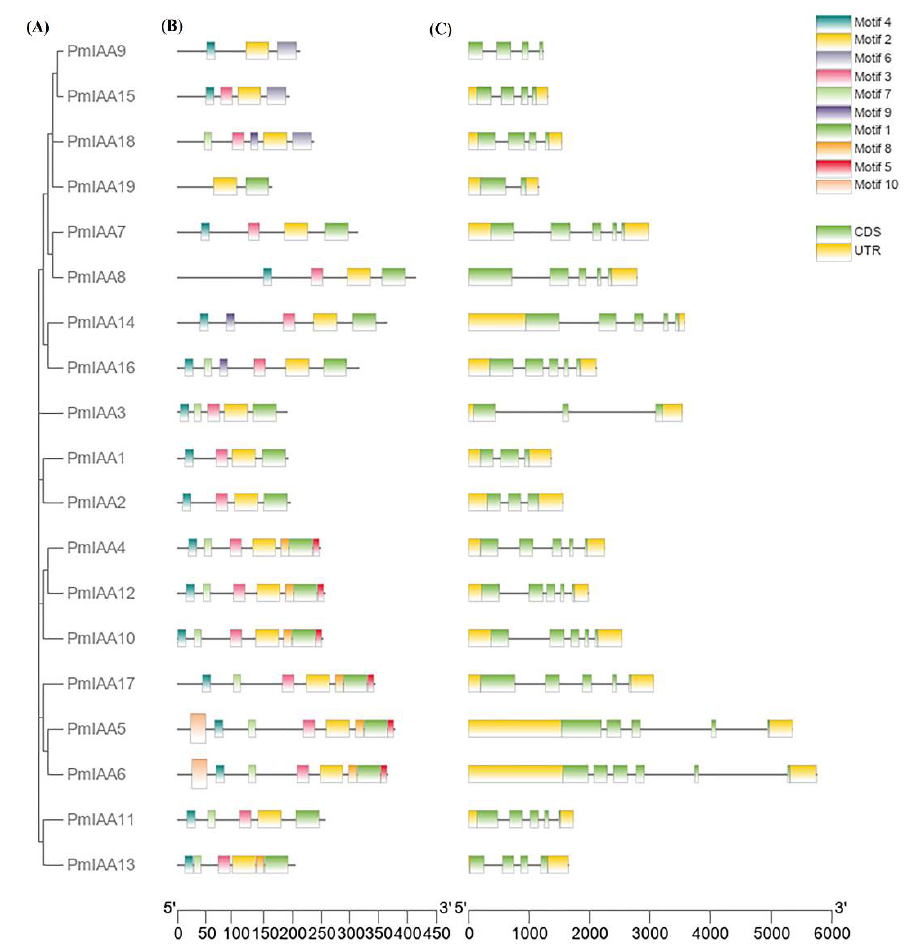
Figure 2. Analysis of phylogeny, gene structure and conserved motif of PmIAAs ( A ) The phylogenetic relationship of PmIAAs was constructed using MEGA 7.0 ( B ) conserved motif distribution of PmIAAs. Ten conserved motifs were labeled with different colors using MEME program ( C ) gene structural organization (CDS, UTR) of PmIAAs. The relative position is uniformly shown based on the Kilobase scale at the bottom of the figures.